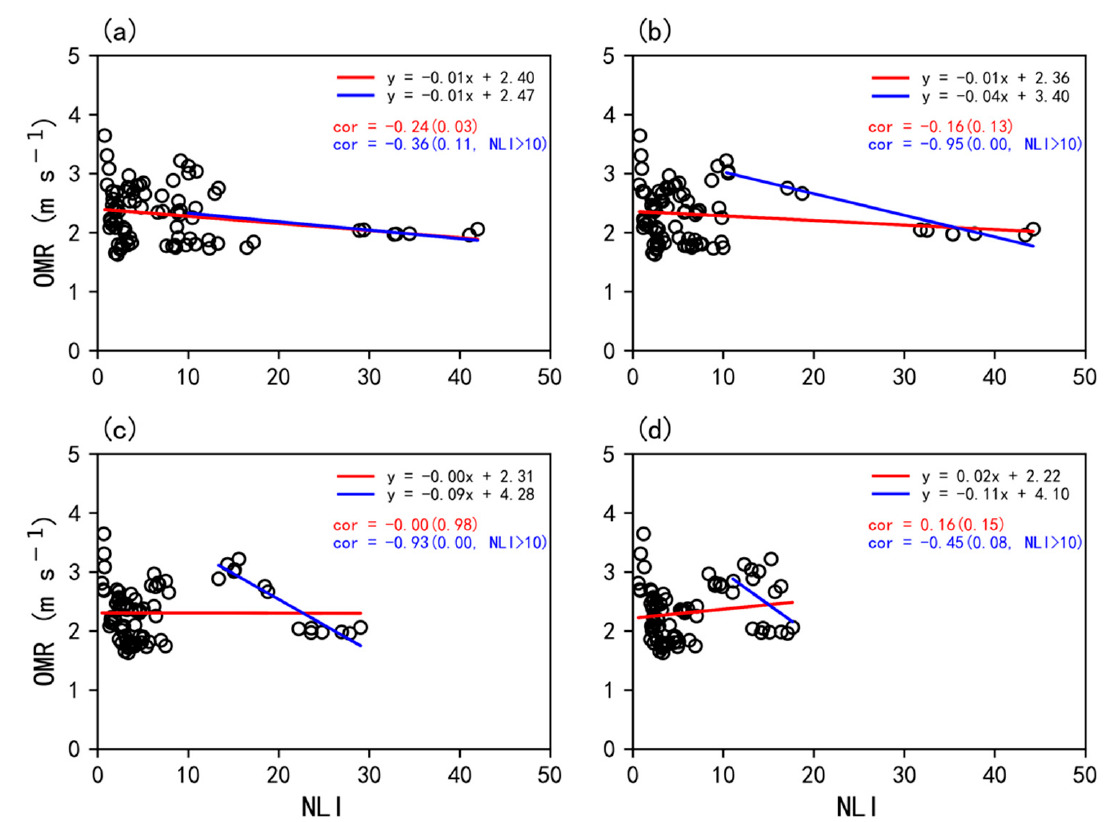
Figure 9. Scatter diagrams of annual OMR (m s − 1 ) against NKL using the fan-sector method when the upstream distance is set to ( a ) 3, ( b ) 5, ( c ) 10, and ( d ) 15 km, with the red and blue lines denoting the fitted lines for all samples and samples of NLI greater than 10 only, respectively.